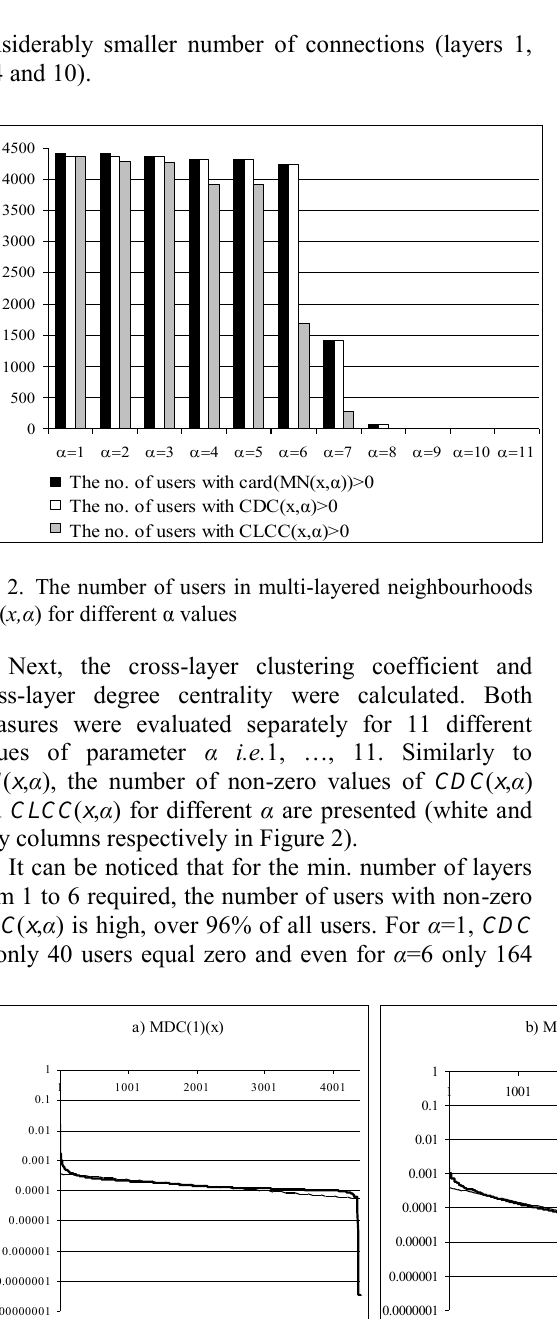
Fig. 3. Values of MDCs (a thick line) and the fitting functions (a thin line) for particular users (X